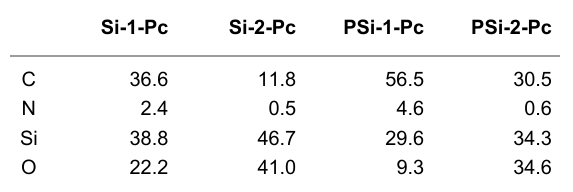
Figure 2: C1s XPS spectral region of Si-1-Pc (a) and PSi-1-Pc (b).